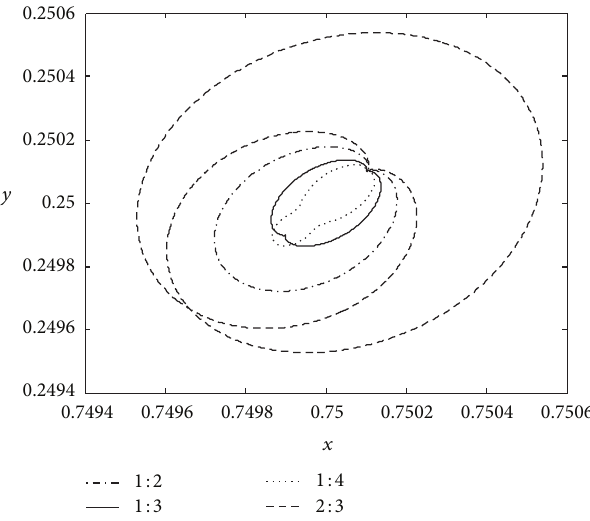
Figure 8: Resonant periodic orbits near the sail equilibrium.